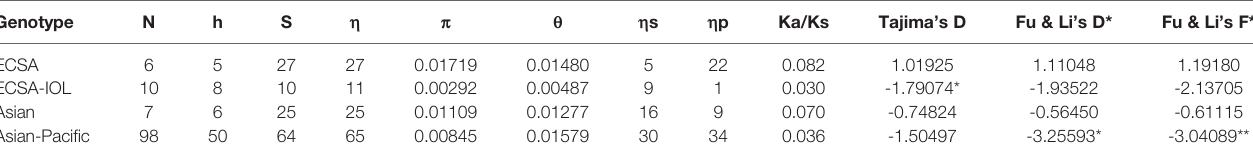
TABLE 2 | Polymorphism analysis of the chikungunya E1 sequences.